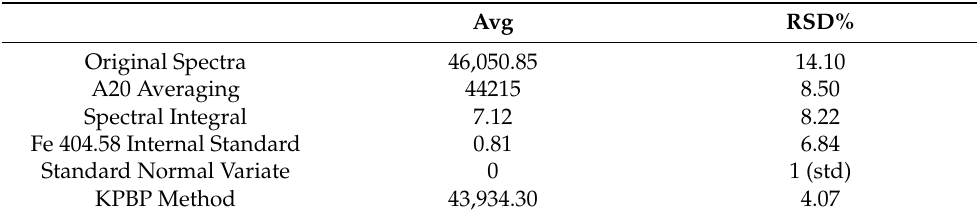
Table 1. Comparing KPBP results with other standardization methods.